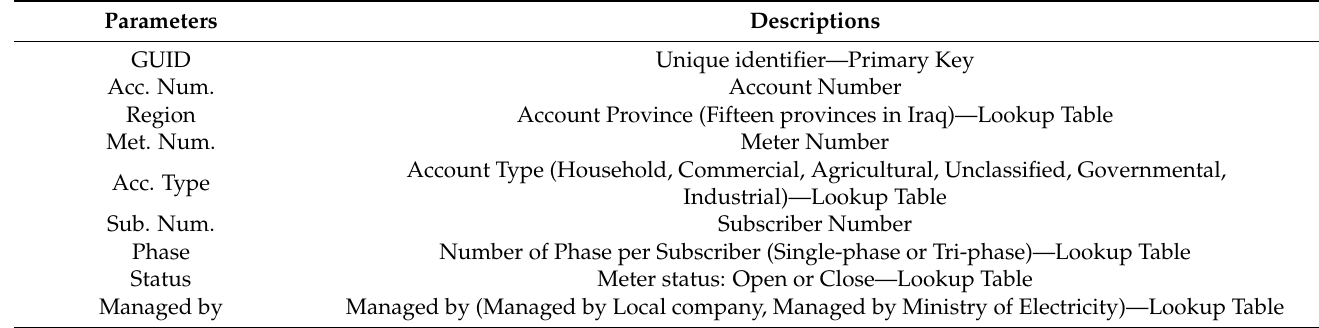
Meter status: Open or Close—Lookup Table